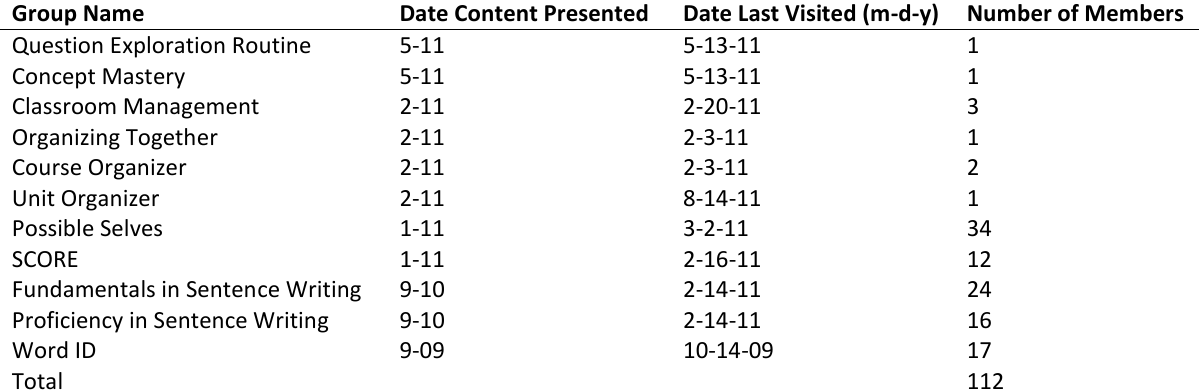
Table 2. SIN-Ning groups by date last visited and number of members. Group